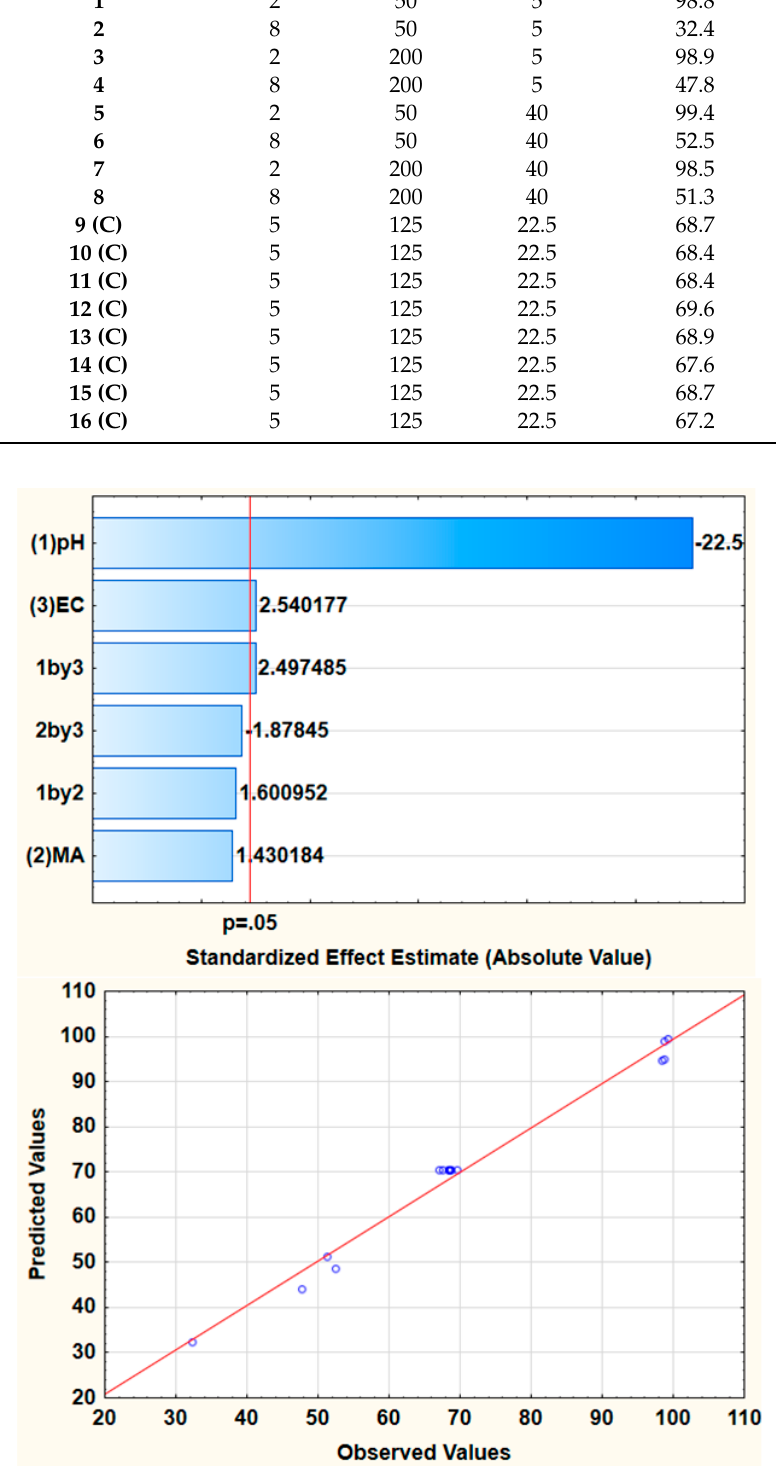
Figure 1. Pareto chart of standardized effects and relationship between actual and predicted %RE for the removal of arsenic.